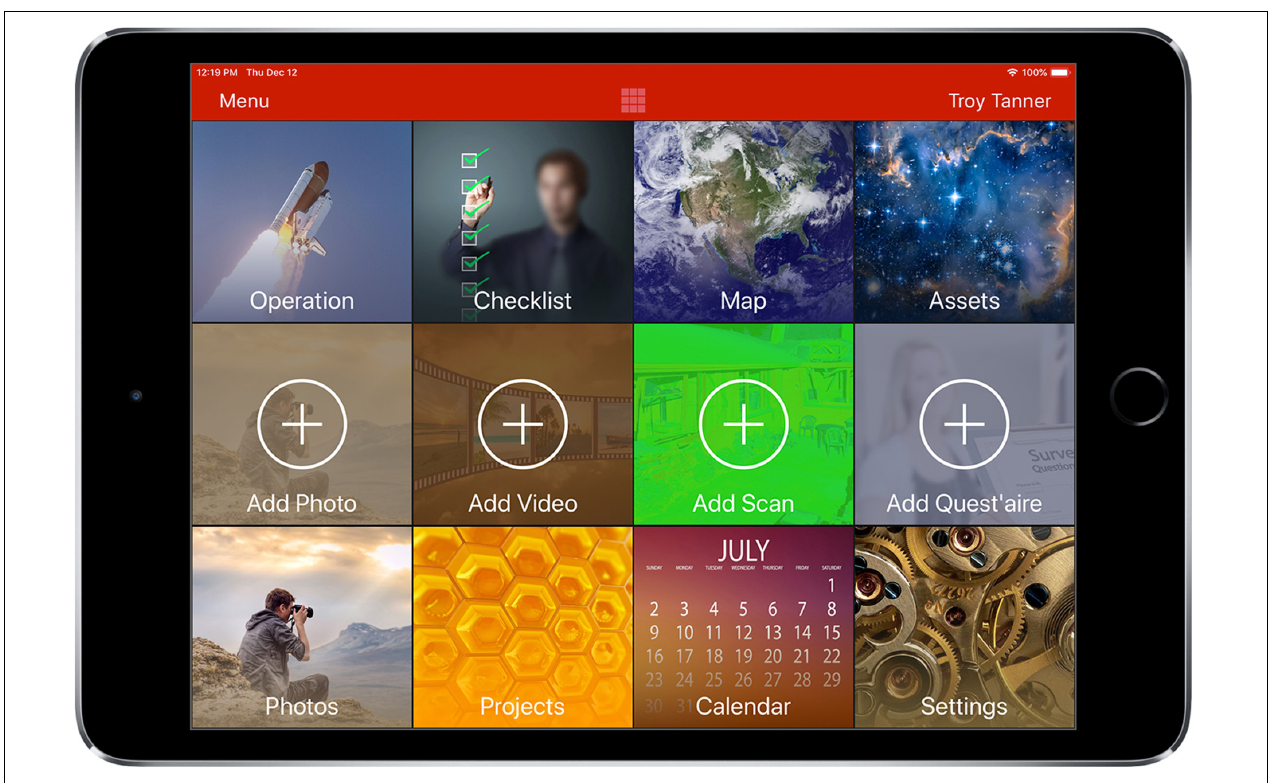
FIGURE 4 | RApp main screen with customizable